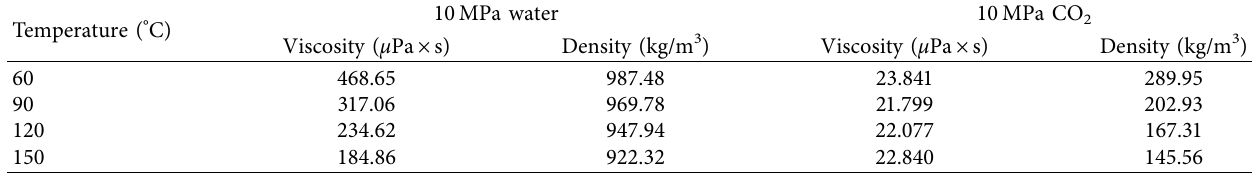
Table 4: The viscosity and density of water and supercritical CO